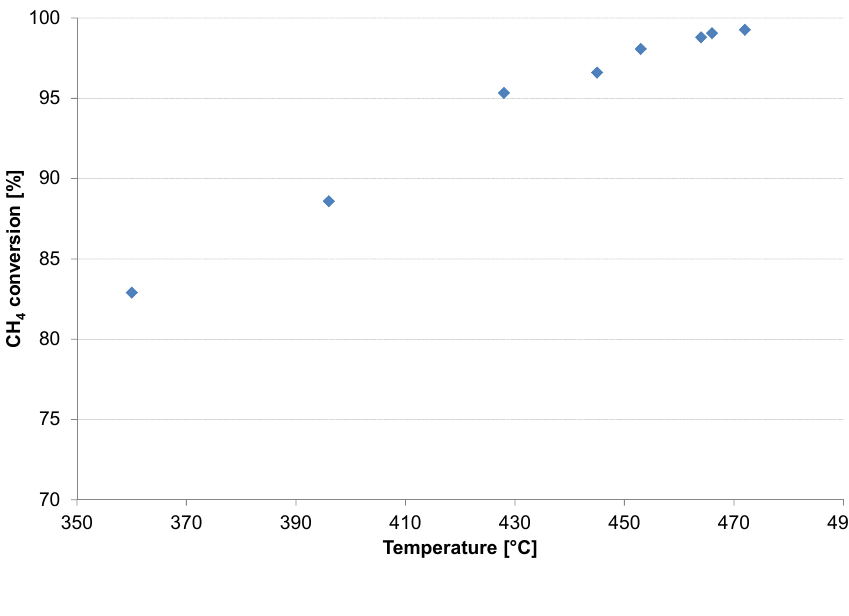
conversion over the universal metal catalyst as a function of Figure 2. CH 4